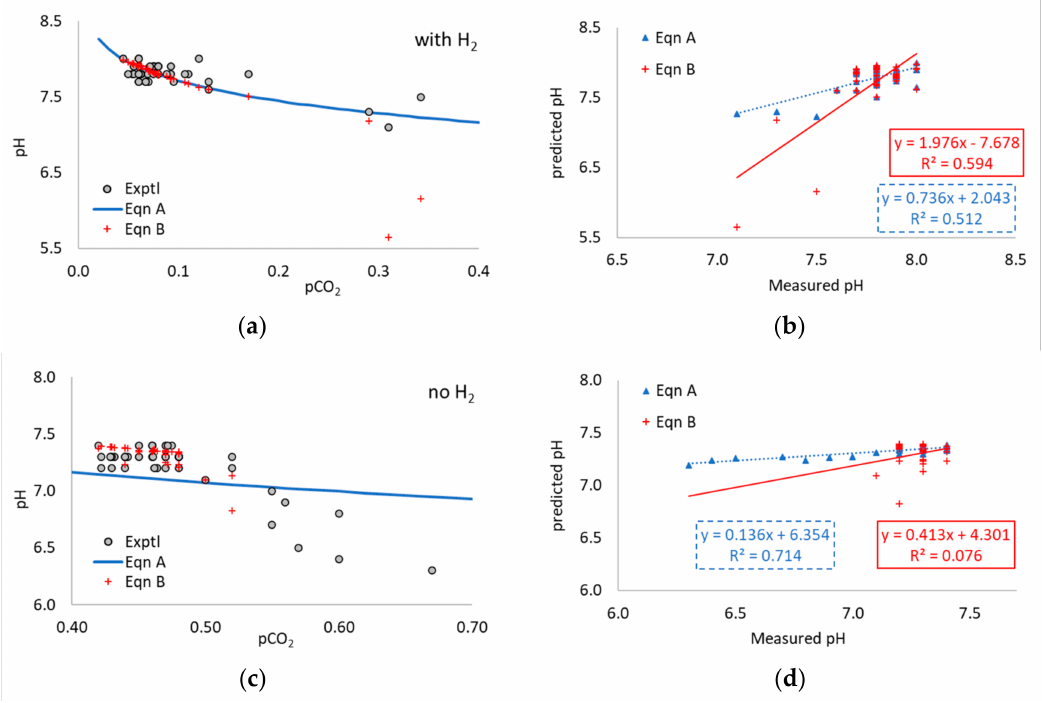
Figure A5. Experimental pCO 2 and pH values and predicted pH from Equations A and B for thermophilic CO 2 biomethanisation of cattle manure and whey with ( a , b ) and without ( c , d ) H 2 addition associated with Luo and Angelidaki [17]. See Table S3 for operating conditions and average results for each phase.